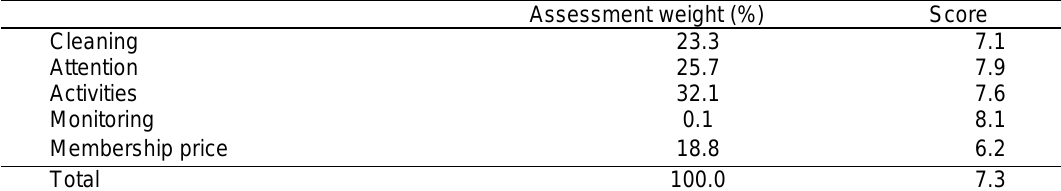
Table 9. Weight of the different aspects in the assessment of the sport